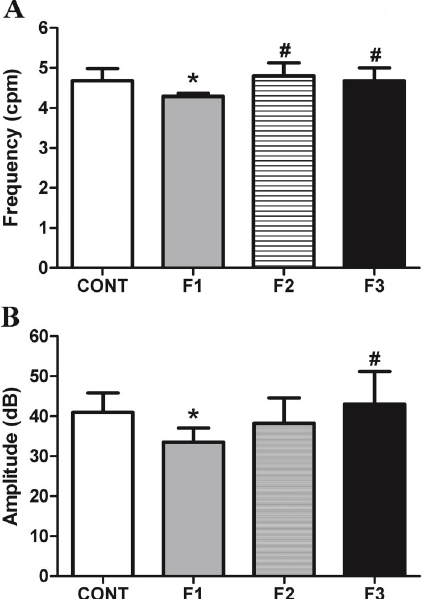
Figure 3. Gastric contractility parameters calculated for the Control group (CONT), monosodium glutamate (MSG)-induced obese rats (F1), obese offspring (F2), and grand offspring (F3). Frequency in contractions per min (cpm) ( A ) and amplitude ( B ) of gastric contractions. Data are reported as means ± SD (n=14 per group). *P o 0.05 compared with CONT, # P o 0.05 compared with F1 (ANOVA followed by Tukey ’ s post hoc